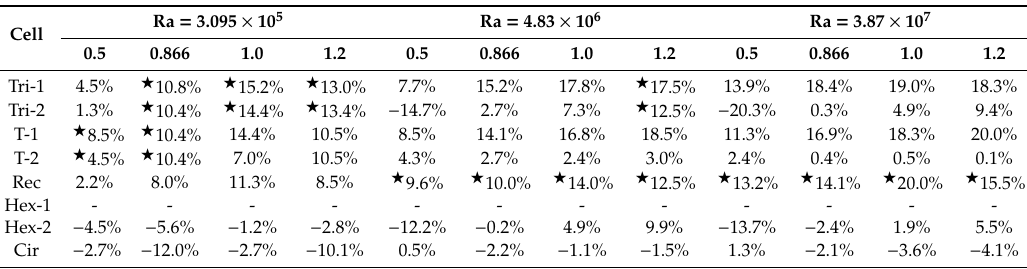
Figure 13. Comparisons of the melting times of the paraffin in the triangular, trapezoidal, rectangular, hexagonal, and circular cells with AR = 0.5, 0.866, 1.0, and 1.2. ( a ) Ra = 3.095 × 10 5 ; ( b ) Ra = 4.83 × 10 6 ; ( c ) Ra = 3.87 × 10 7 . Table 3. The time-saving ratios of the cells with different aspect ratios ( ★ represents the maximum value, Tri, T, Rec, Hex, and Cir are abbreviated forms of triangular, trapezoidal, rectangular, hexagonal, and circular cells, respectively).